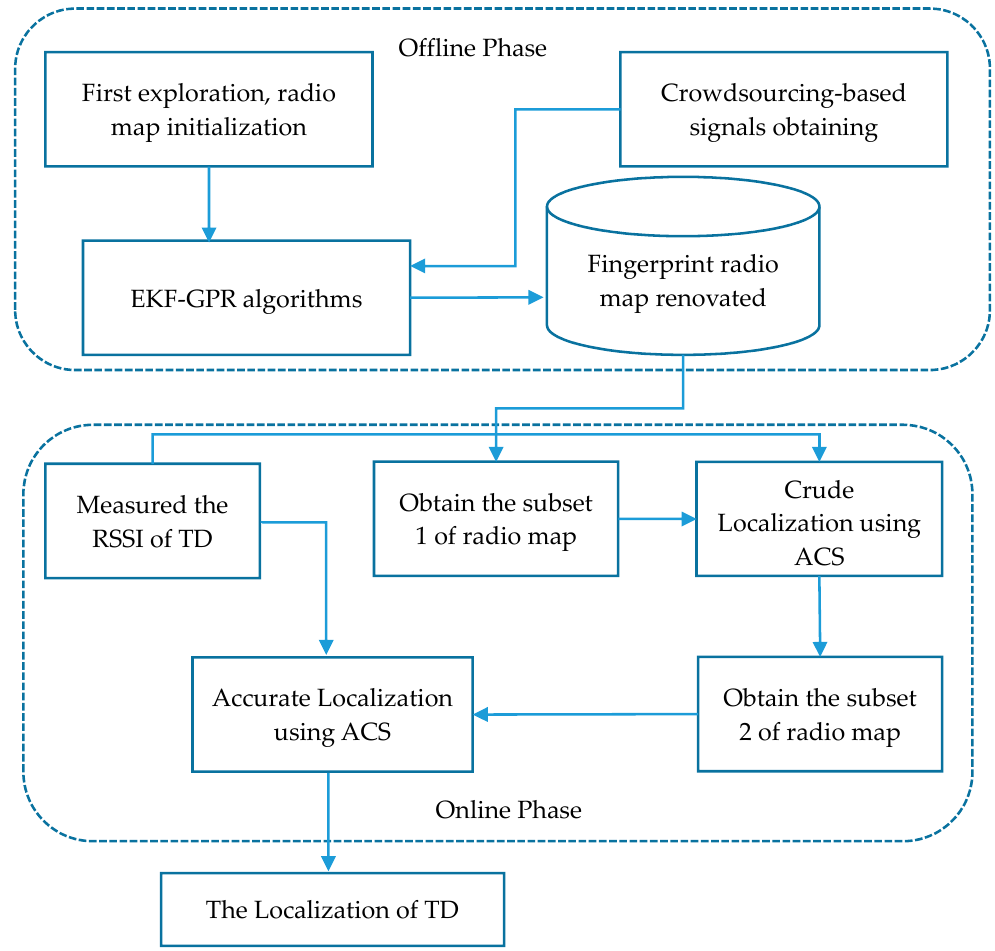
Figure 2. System overview of the Fingerprint Renovation System (FRS). EKF, Extended Kalman Filter; GPR, Gaussian Process Regression; RSSI, received signal strength indicator; TD, target device; ACS, Adjusted Cosine Similarity.